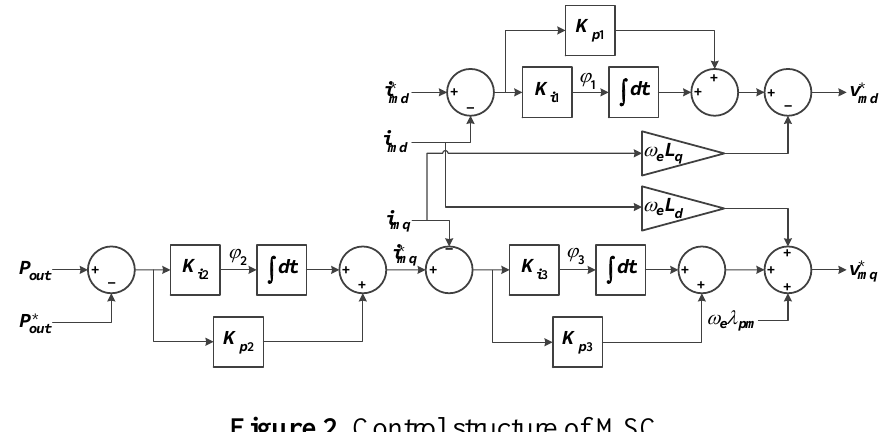
Figure 2. Control structure of MSC.